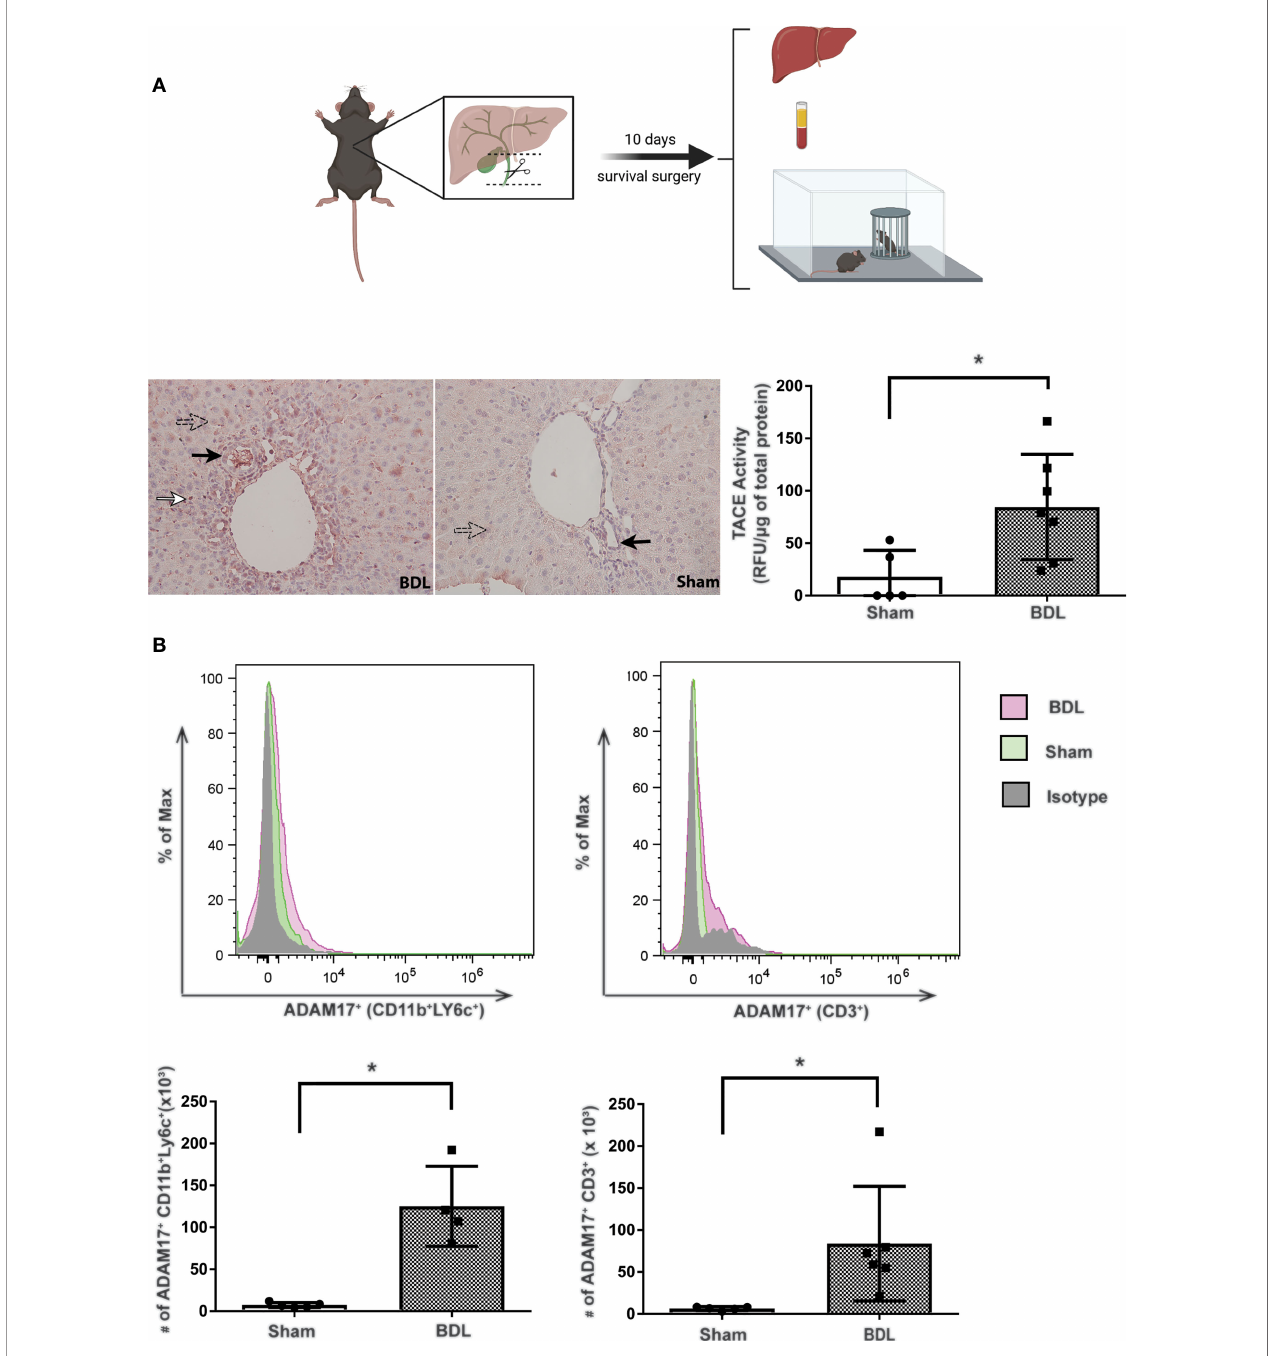
FIGURE 1 | Increased hepatic ADAM17 activity and protein expression in cholestatic mice. Diagram of experimental design. Bile duct ligation (dotted line) with resection in between ligatures was performed in BDL mice. Mice were overtly cholestatic 10 days post surgery at which point liver histology, liver immune cell isolation, liver TACE activity, serum biochemistry and behavioral studies were performed. (A) Qualitative hepatic ADAM17 protein expression in liver tissue from day 10 BDL and sham mice. Representative images illustrating positive ADAM17 staining (red colour) being mainly localized to hepatocytes (perforated arrows), cholangiocytes (black arrows), and immune cells within in fl ammatory in fi ltrates (white arrows). ADAM17 protein expression was also detected in sham liver, however the increased ADAM17 expression was more readily observed in BDL livers. Images acquired at 20X and are representative of similar fi ndings in n = 7 BDL and n = 5 sham mice. Quantitative hepatic ADAM17 enzymatic activity (expressed as Relative Fluorescent Units/ m g of total liver protein). The mean ± SEM was from n = 7 BDL and n = 5 Sham mice; *p < 0.05. These experiments were repeated twice with similar results. (B) Increased ADAM17 expression in hepatic tissue derived immune cells. Flow cytometry histogram and absolute cell count of ADAM17+ expression in monocytes and T lymphocytes isolated from day 10 BDL and sham livers. Absolute cell counts are represented as mean ± SEM for data from n = 4-6 BDL and n = 4-5 sham mice; *p < 0.05). This experiment was repeated twice with similar